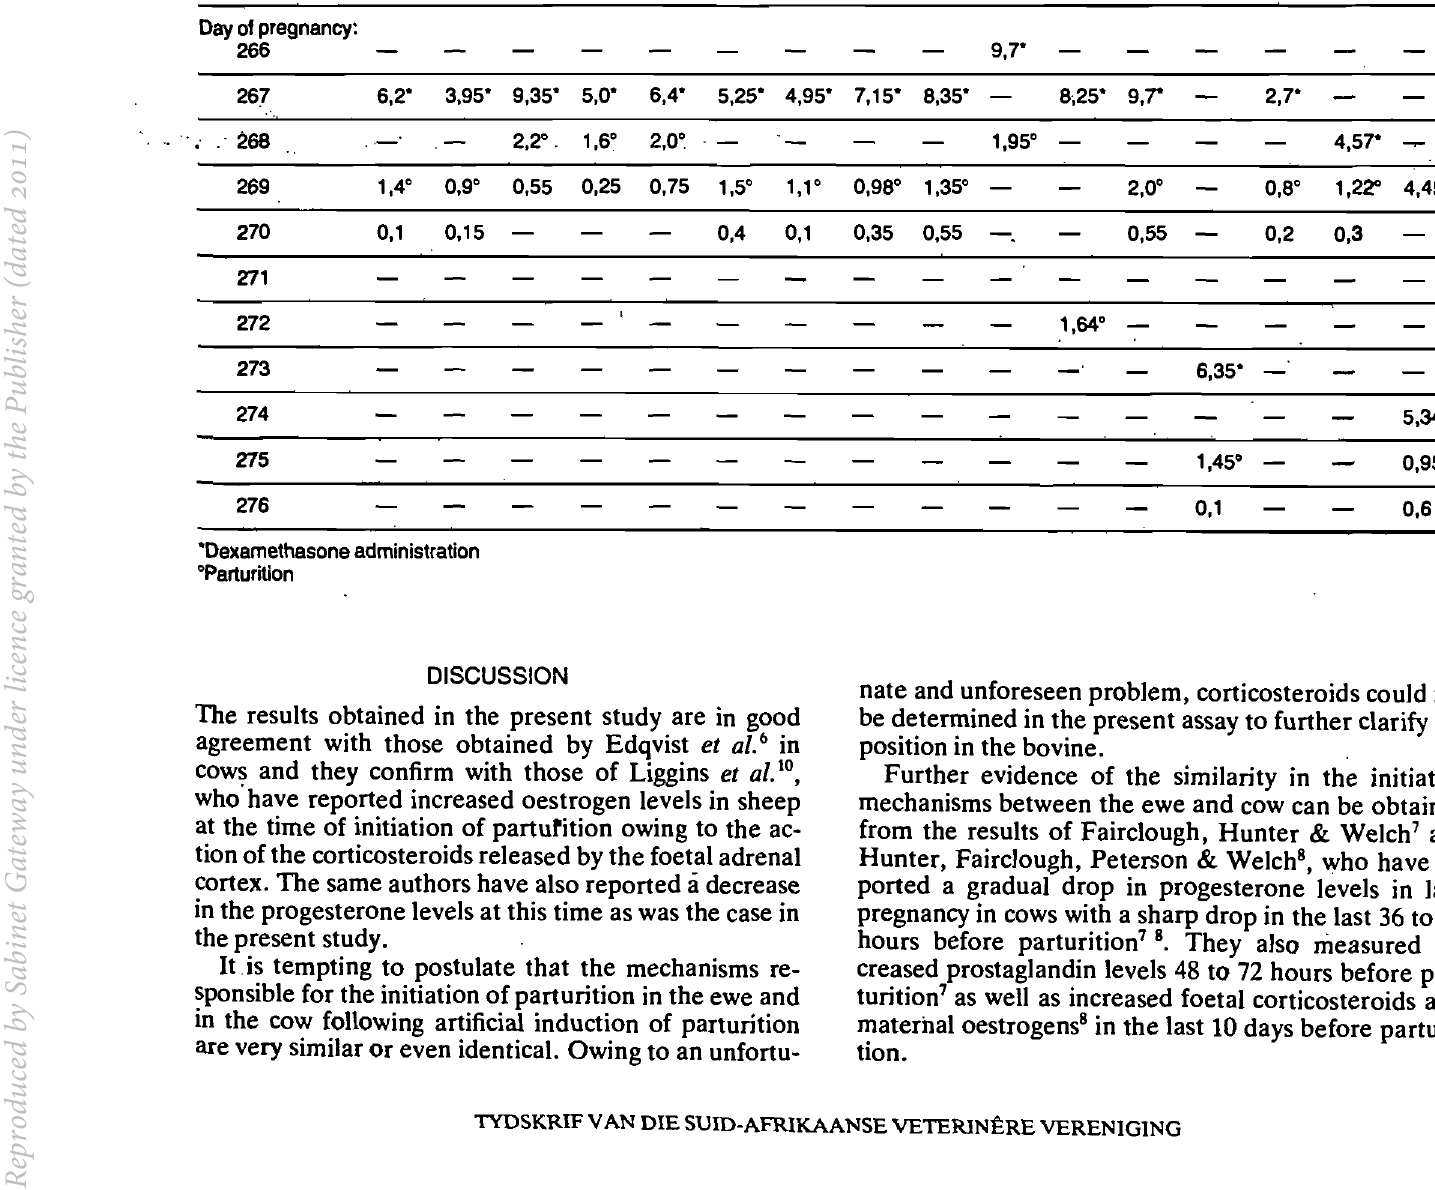
Table 2: PLASMA PROGESTERONE LEVELS AT THE TIME OF INDUCED PARTURITION (NG PER ML) Heifer